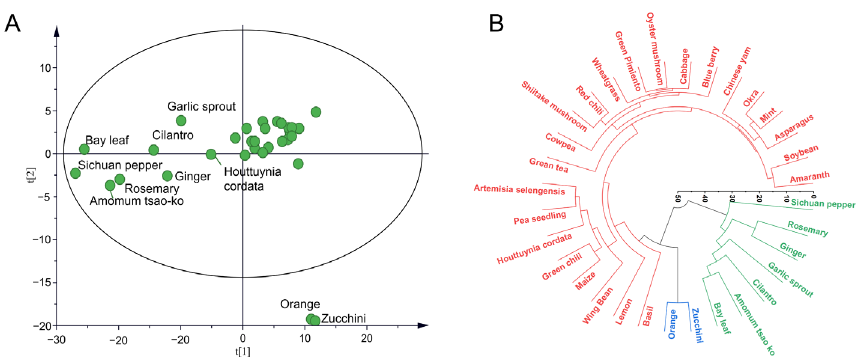
Figure 2. Matrix typing by MEs: ( A ) the score plots of PCA modeling; ( B ) the dendrogram of HCA colored by classifying results.